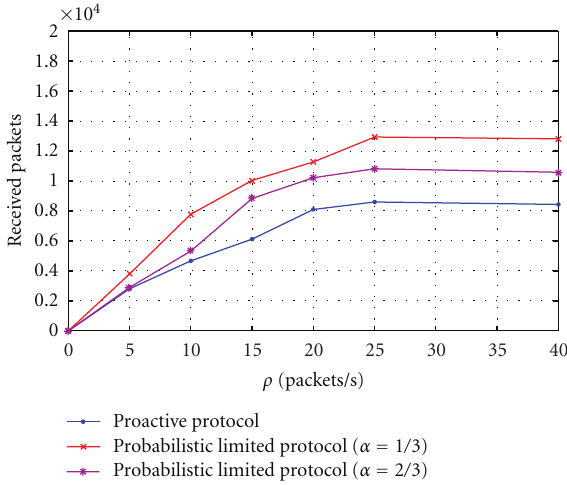
Figure 8: Percentage of valid probabilistic routes as a function of the elapsed time, V = 10 m/sec. Figure 9: Throughput as a function of the tra